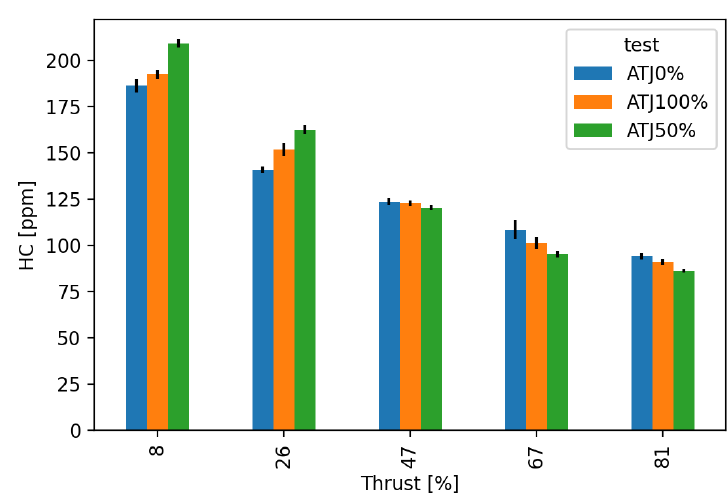
Figure 15. GTM-140/ATJ: HC emission. Figure 16. GTM-140/ATJ: NO x Figure 16. GTM-140/ATJ: NO x emissions.